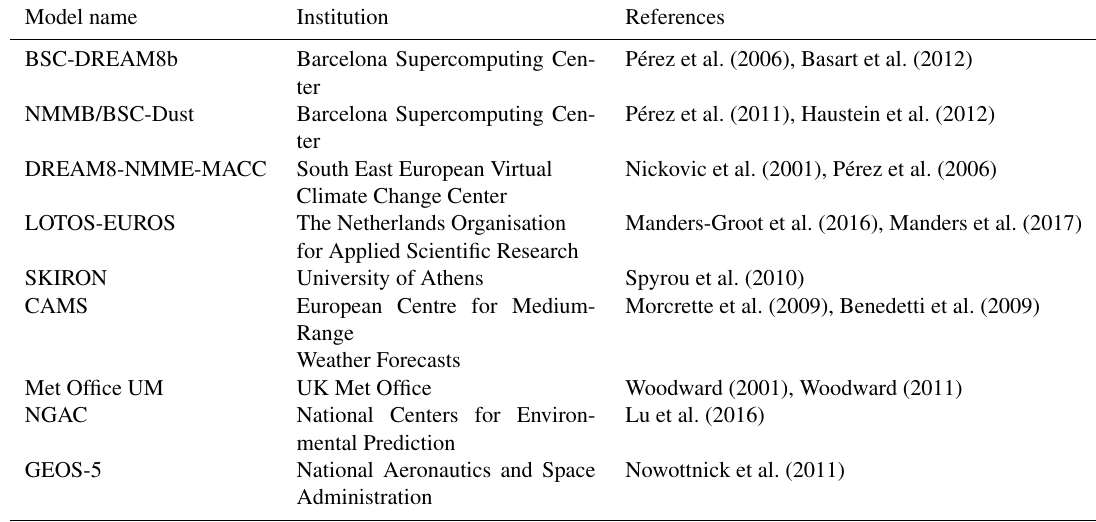
Table 1. Overview on operational mineral dust forecasting models.